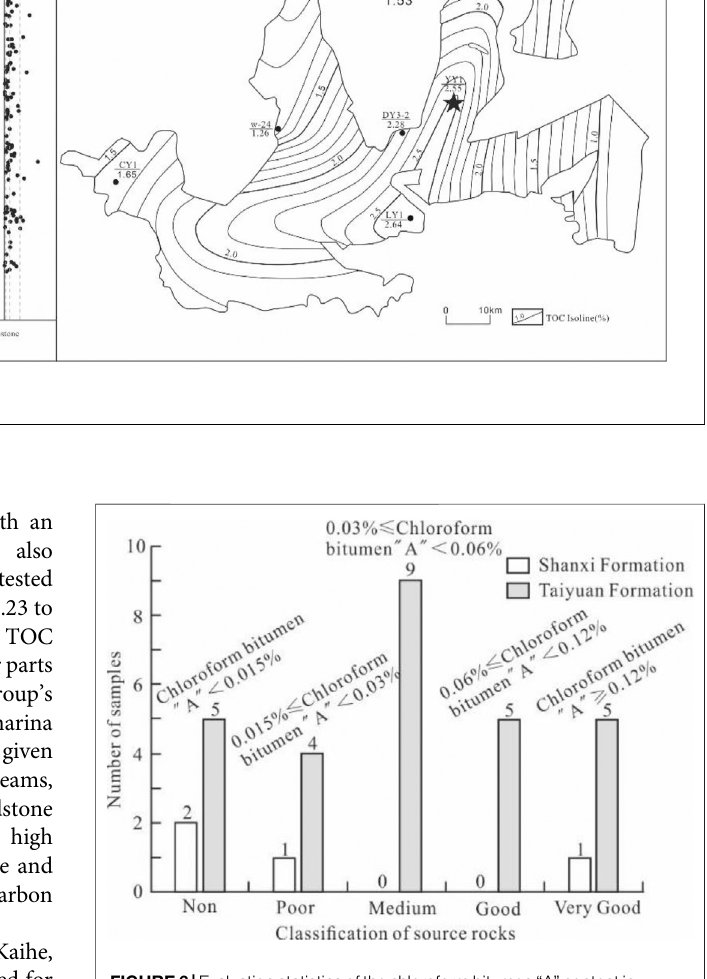
Frontiers in Earth Science |